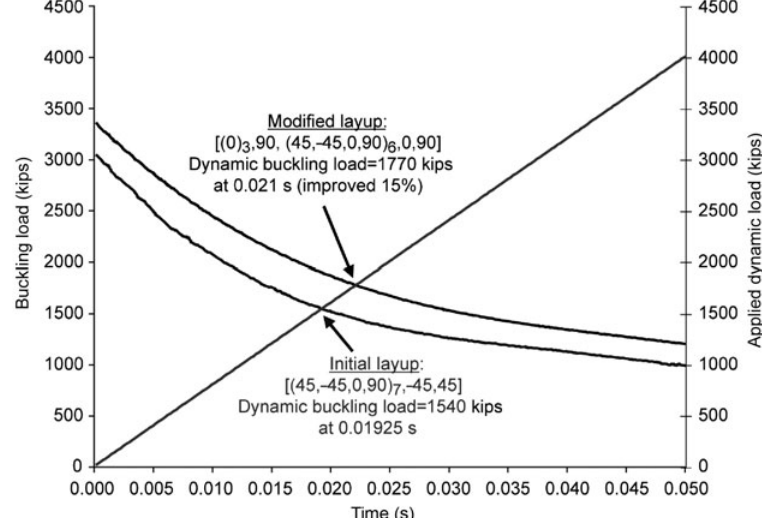
Figure 11 Benefi t of using 0 ° and 90 ° graphite fi bers in plies 1 and 30 on the dynamic buckling of a graphite epoxy composite shell. (1 kip = 4.45 KN.)